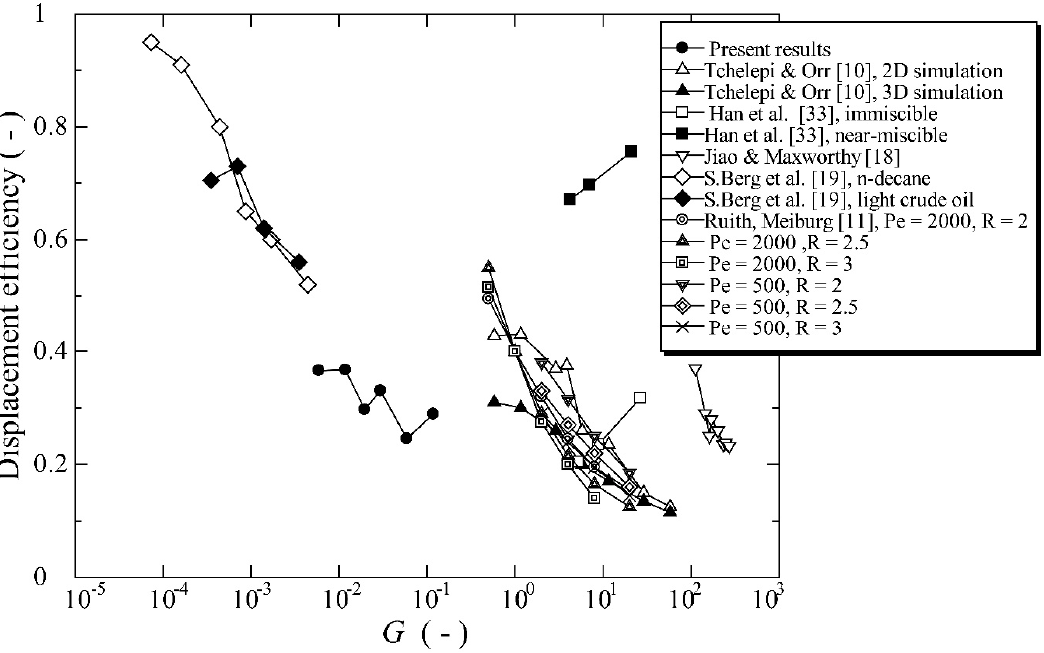
Figure 7. Displacement efficiency vs. the gravity number. Tchelepi and Orr [10], recovery at breakthrough obtained by two-dimensional and three-dimensional numerical simulations Ruith and Meiburg [11], recovery at the breakthrough obtained by two-dimensional numerical simulations. R is the parameter relates the viscosity and concentration. Jiao and Maxworthy [18], miscible flow in a Hele-Shaw cell. Berg et al. [19], n -decane and light crude oil displaced by carbon disulfide in Berea sandstone core at one PV injection. Han et al. [33], n -decane displaced by CO 2 at immiscible and near-miscible condition in a Berea sandstone plate.